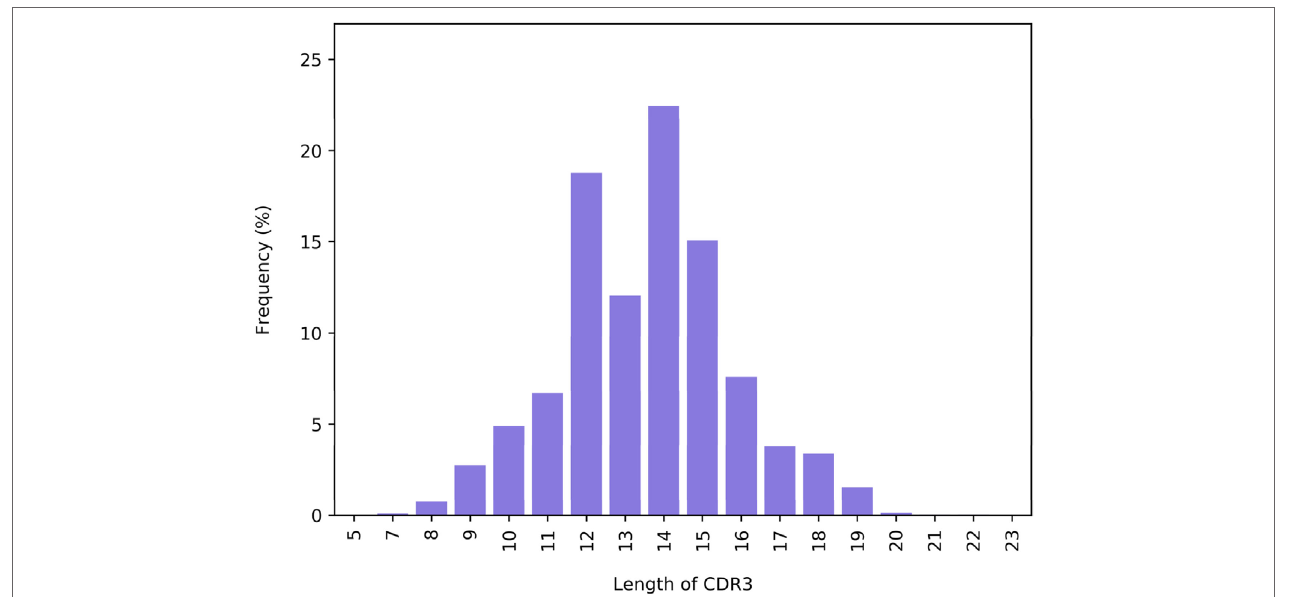
FIguRe 5 | The distribution of CDR3 length (number of amino acids) in a next-generation sequencing